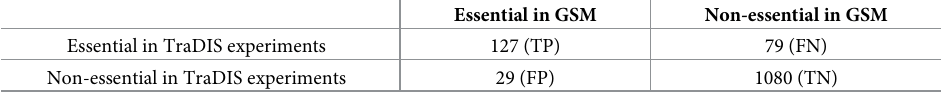
Table 3. Confusion matrix showing the number of true positives (TP), true negatives (TN), false positives (FP) and false negatives (FN), obtained by comparing TraDIS results with GSM predictions. Essential in GSM Non-essential in GSM Essential in TraDIS experiments Non-essential in TraDIS